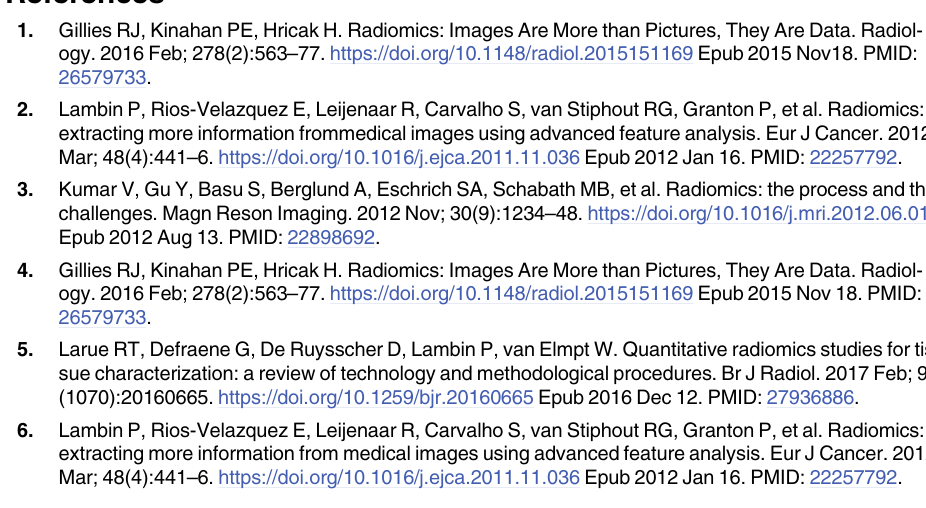
S2 Fig. Performance metrics evaluation of predictive models using RF. (TIFF) S3 Fig. Performance metrics evaluation of predictive models using SVM. (TIFF) S1 Table. Patient’s characteristics. (PDF) S2 Table. PET/CT and MRI protocols in Brest (A), Nantes (B), and McGill (C). (PDF) S1 Data.